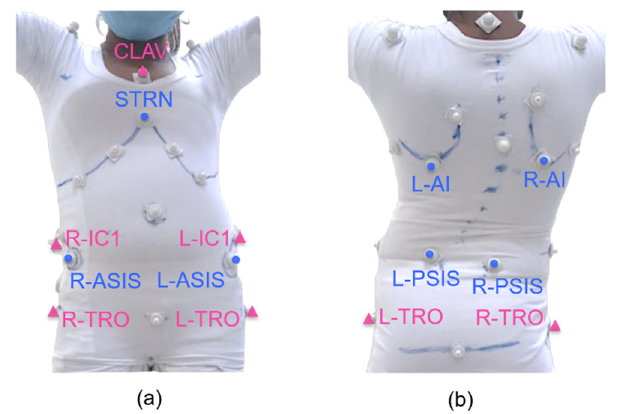
Figure 1. ( a ) Anterior and ( b ) posterior view of an AIS patient with spherical markers placed at anatomical landmarks. Magenta markers (triangle) are only placed on the patient’s body, and blue markers (circle) represent markers placed on the patient’s body, as well as the pre- and post-rectification moulds.